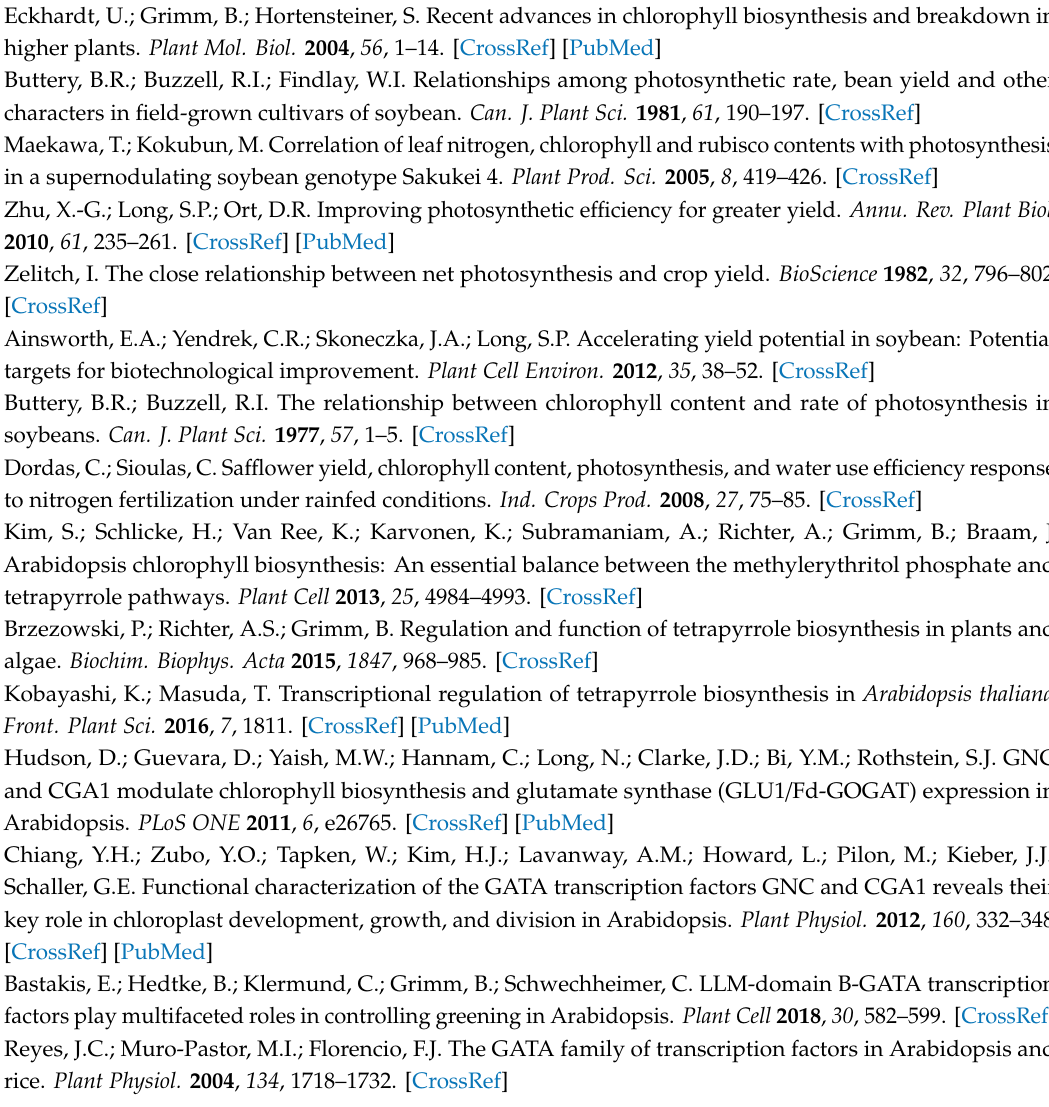
Figure S1: Multiple alignment of deduced amino acids of GmGATA58 with other three GATA factors. Figure S2: Restoration of greening defect of Arabidopsis thaliana gnc mutant by GmGATA58 overexpression. Table S1: Putative cis -acting regulatory elements predicted in the GmGATA58 promoter sequence. Table S2: Primers used in this study for cloning, vector construction, semi-quantitative RT-PCR and qPCR